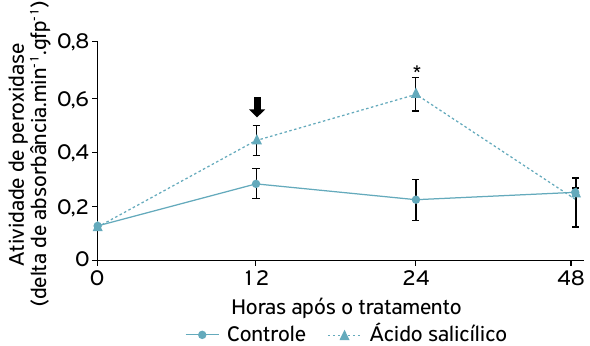
Figura 3. Atividade de peroxidase em mudas de maracujá‑amarelo tratadas com ácido salicílico 2,5 mM e etanol 10% (controle) em diferentes tempos de coleta.